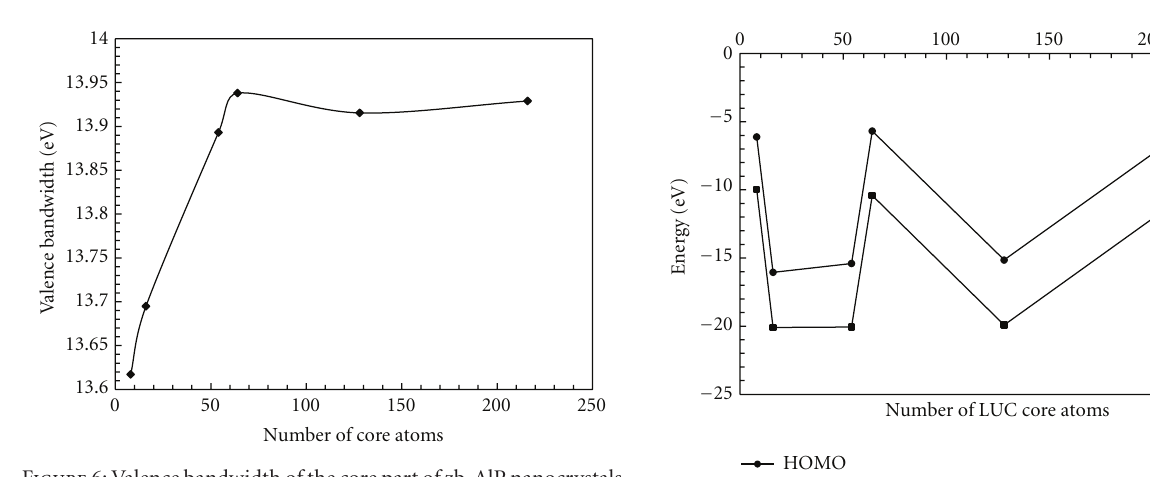
Figure 6: Valence bandwidth of the core part of zb-AlP nanocrystals as a function of core atoms.